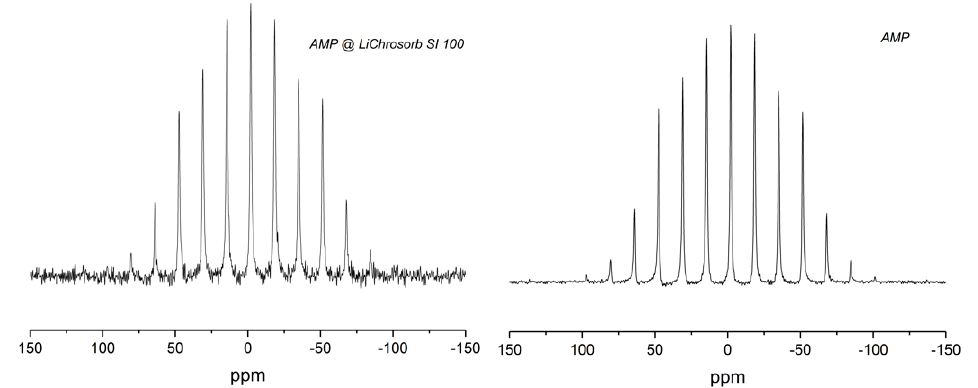
Figure 2. 31 P magic ‐ angle spinning (MAS) NMR ‐ spectrum of LiChrosorb Si 100 loaded with adenosine monophosphate (AMP) ( 2 ) (left) and of neat AMP (right), measured at a spinning frequency of 2 kHz.